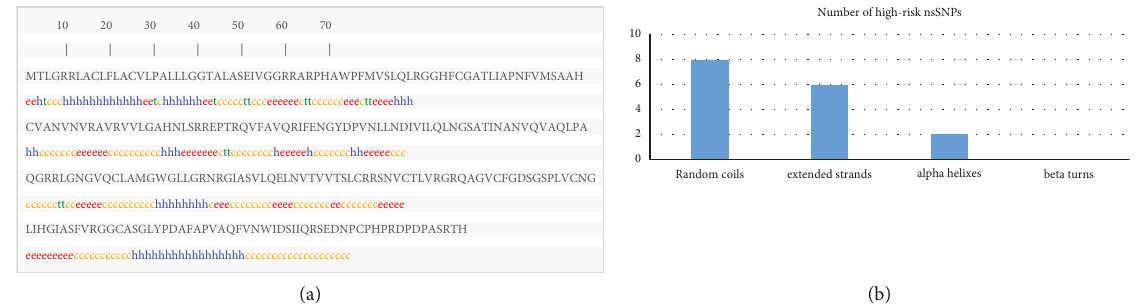
Figure 6: Sequence conservation analysis of the ELANE protein using ConSurf web server.